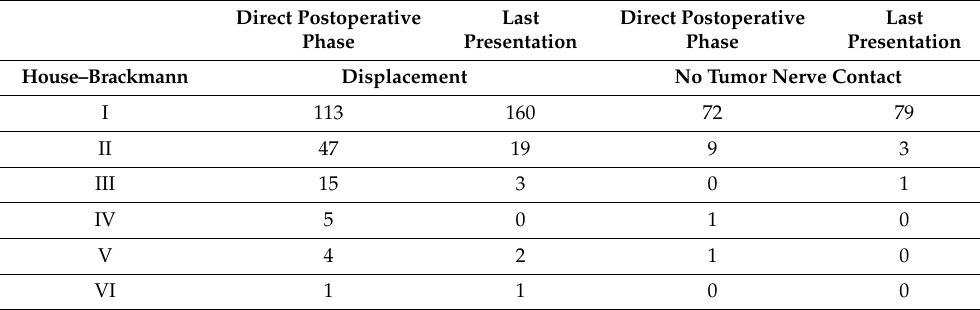
Table 5. Comparative analysis of the patient groups with displacement of the facial nerve and without any contact to the nerve concerning postoperative facial nerve